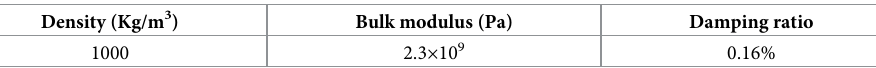
Table 5. Material properties of liquid